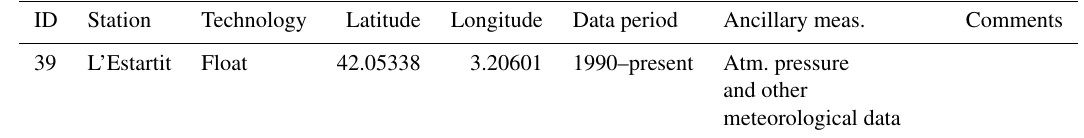
Table A6. Station operated by Josep Pascual (meteorological observer, Meteolestartit/CSIC) in Catalonia